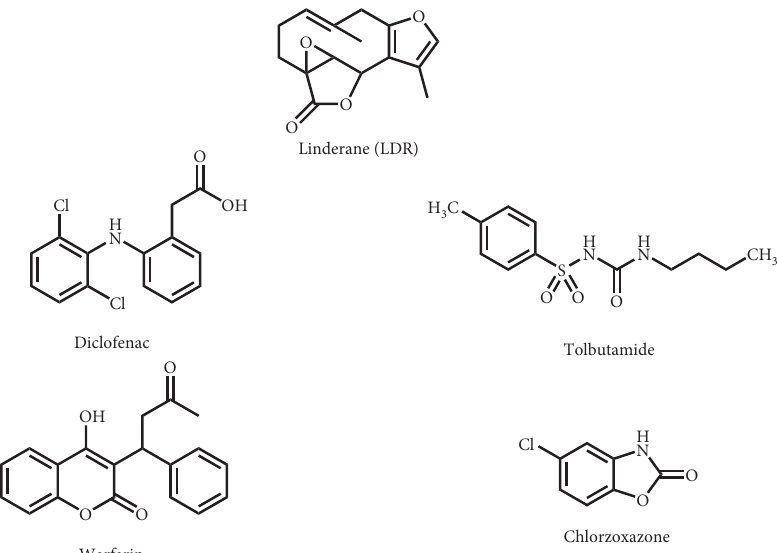
Figure 1: Structures of LDR, diclofenac, tolbutamide, warfarin, and